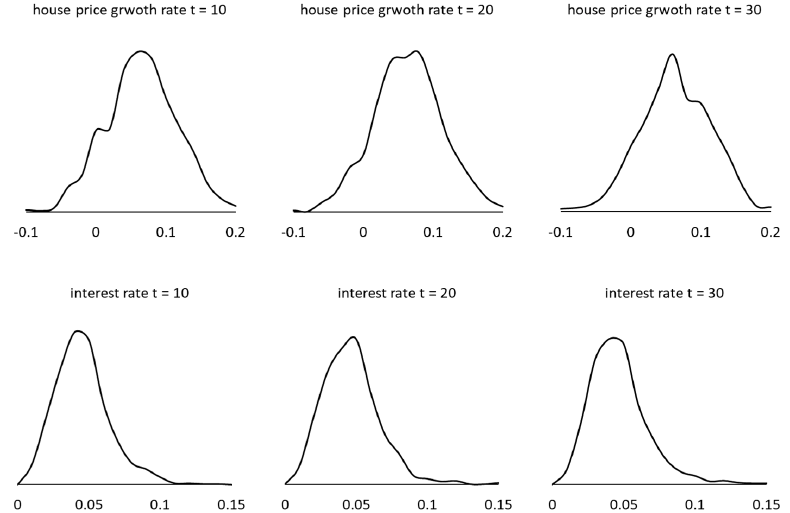
Figure 7. Simulated density functions of future house price growth rates and interest rates after 10, 20 and 30 years (from the start of 2019).